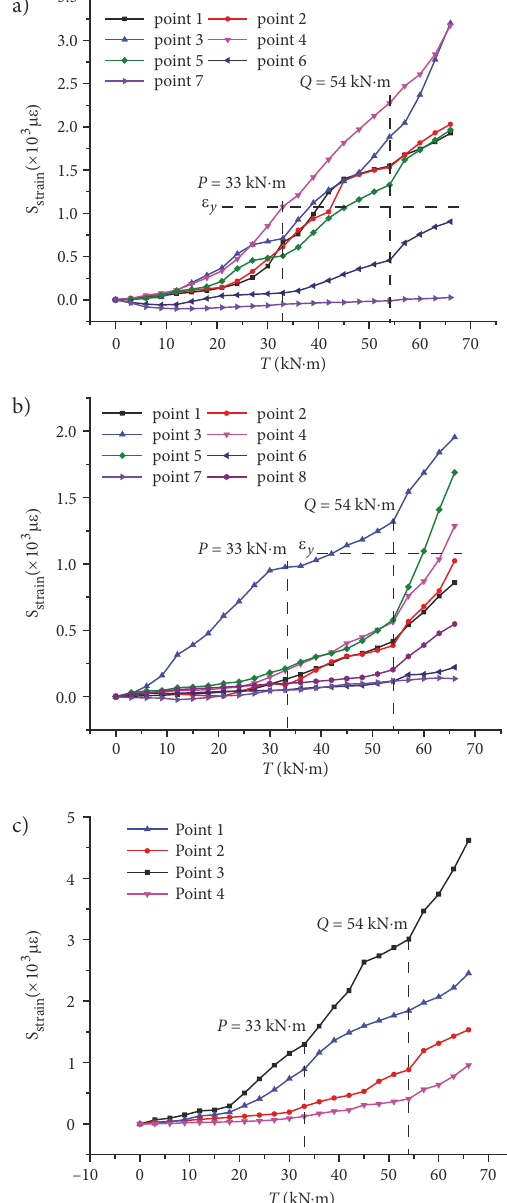
Figure 5. The strain-based stressing state mode with the increasing load: a – the S strain - T curves for longitudinal reinforcement; b – the S strain - T curves for stirrup; c – the S strain - T curves for